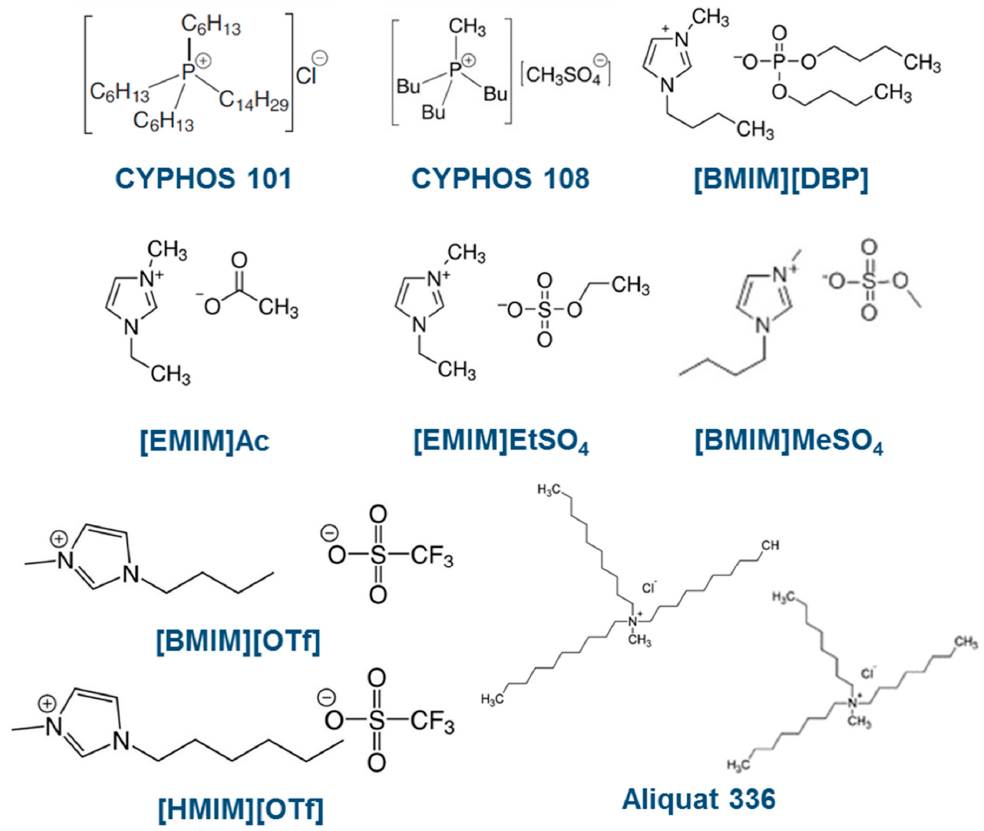
Figure 3. Structure of the selected ILs (Ionic Liquids).